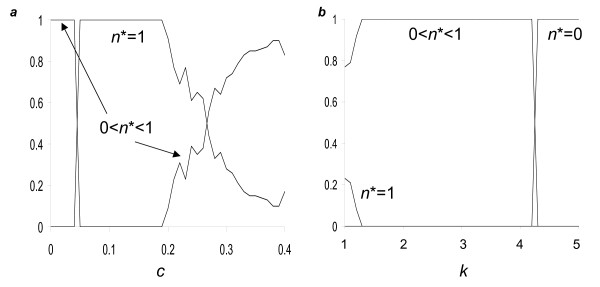
The fraction of simulations in Model 2 leading to different local optima. Results based on 100 simulations in which initial levels of n, y, and z are each set to a random number between zero and one, inclusive. These simulations produced one of three equilibria: n* = 0, 0 <n* < 1 or n* = 1. Caption a effect of the cost of cooperator dispersal (c) with P = Q = 0.3, s = 0.5, k = 2, e = 0.2; caption b effect of effective group size (k) with P = Q = 0.2, s = 0.6, e = 0.2, c = 0.3.